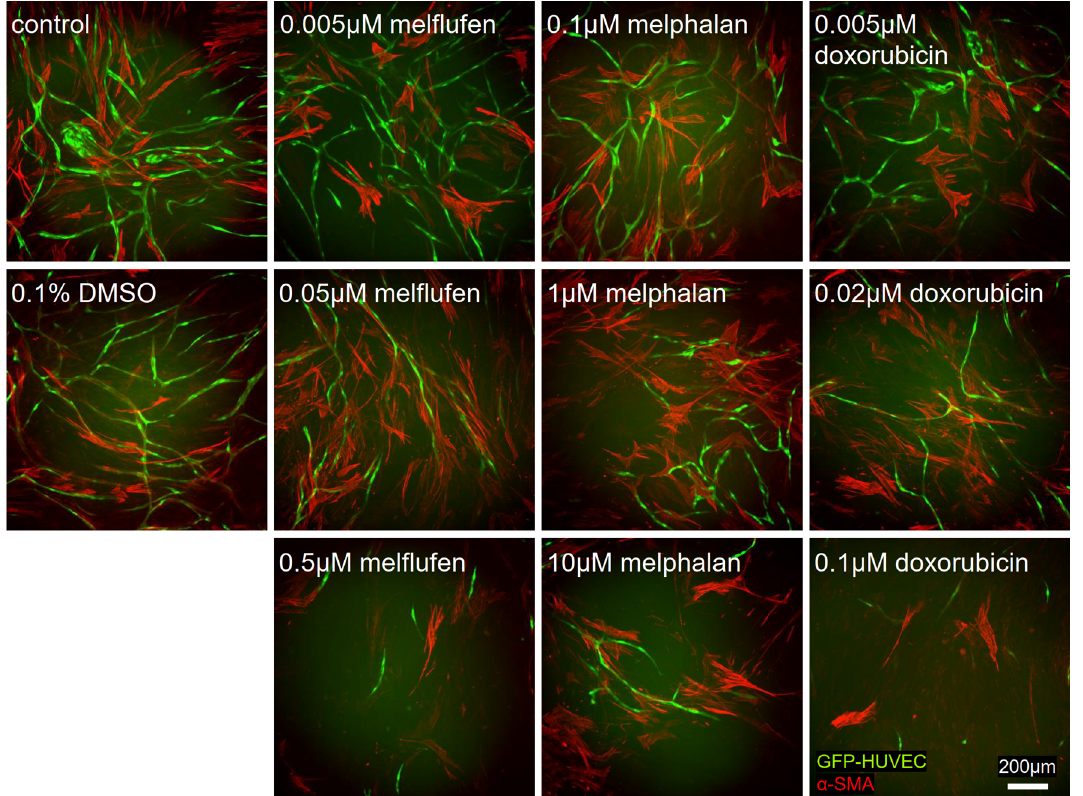
Figure 14. Drug effect on vascular network formation. Vascular networks formed by co-culturing green fluorescent protein-labeled human umbilical vein endothelial cells (GFP-HUVECs, green) and BMSCs for 7 days in the presence of drugs or DMSO at the indicated concentrations. BMSCs are stained for pericytic marker α smooth muscle actin ( α -SMA) shown in red. Scale bar: 200µm.